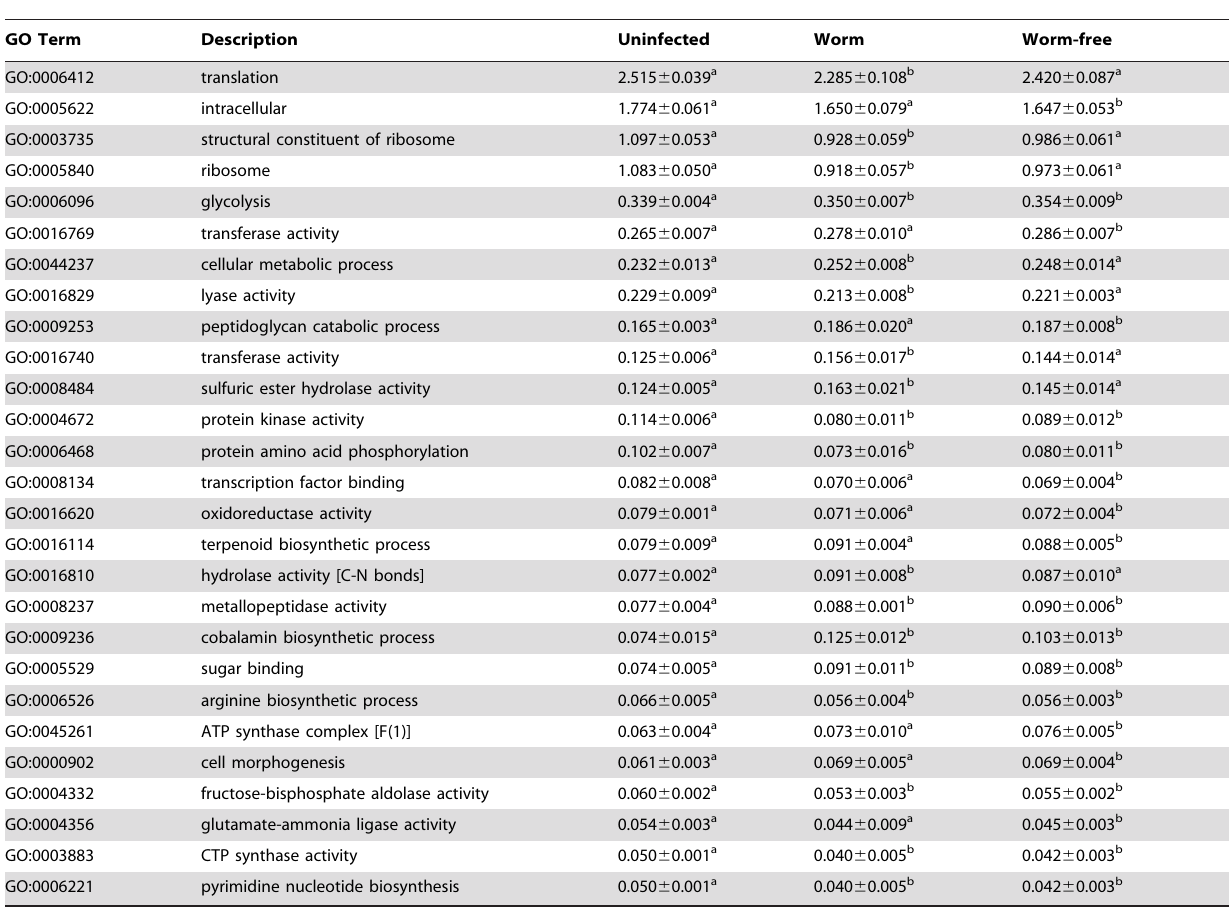
Table 3. Gene Ontology (GO) terms significantly affected by helminth